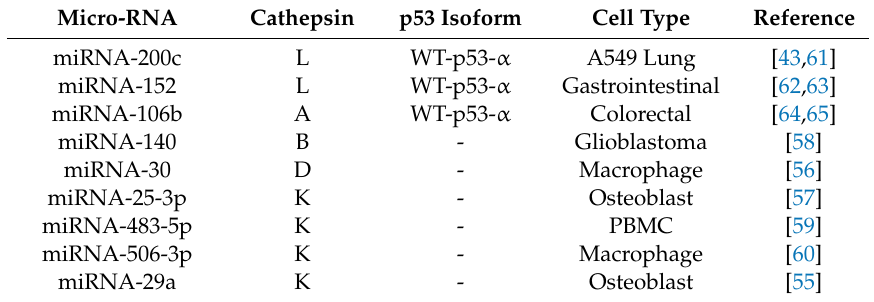
The expression of micro-RNAs connected with cathepsin gene expression are highlighted in conjunction with specific p53 isoforms and cell types they have been collectively characterized in (WT-p53, wild-type p53;